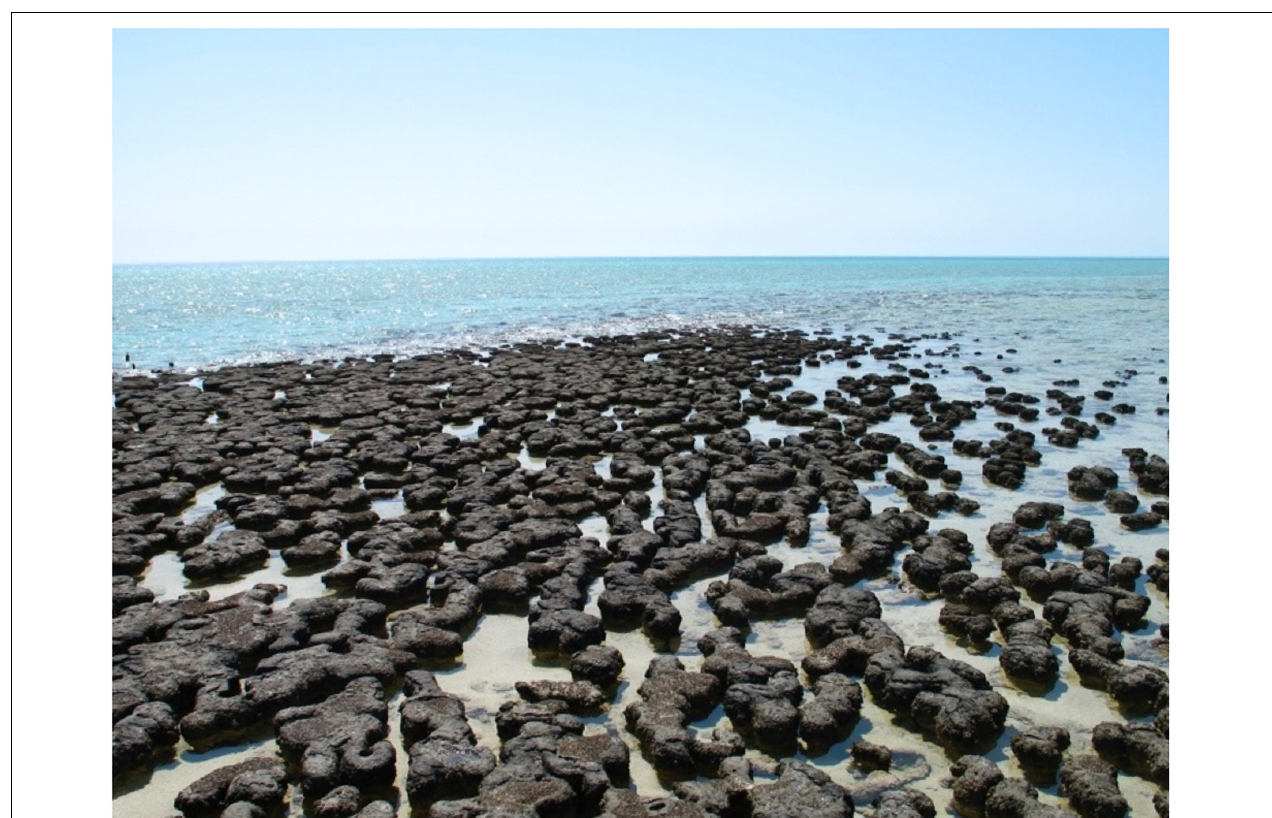
FIGURE 1 | Stromatolites at Hamelin Pool, Western Australia, 4 October 2007. Photograph kindly provided by Dr. Catherine Colas des